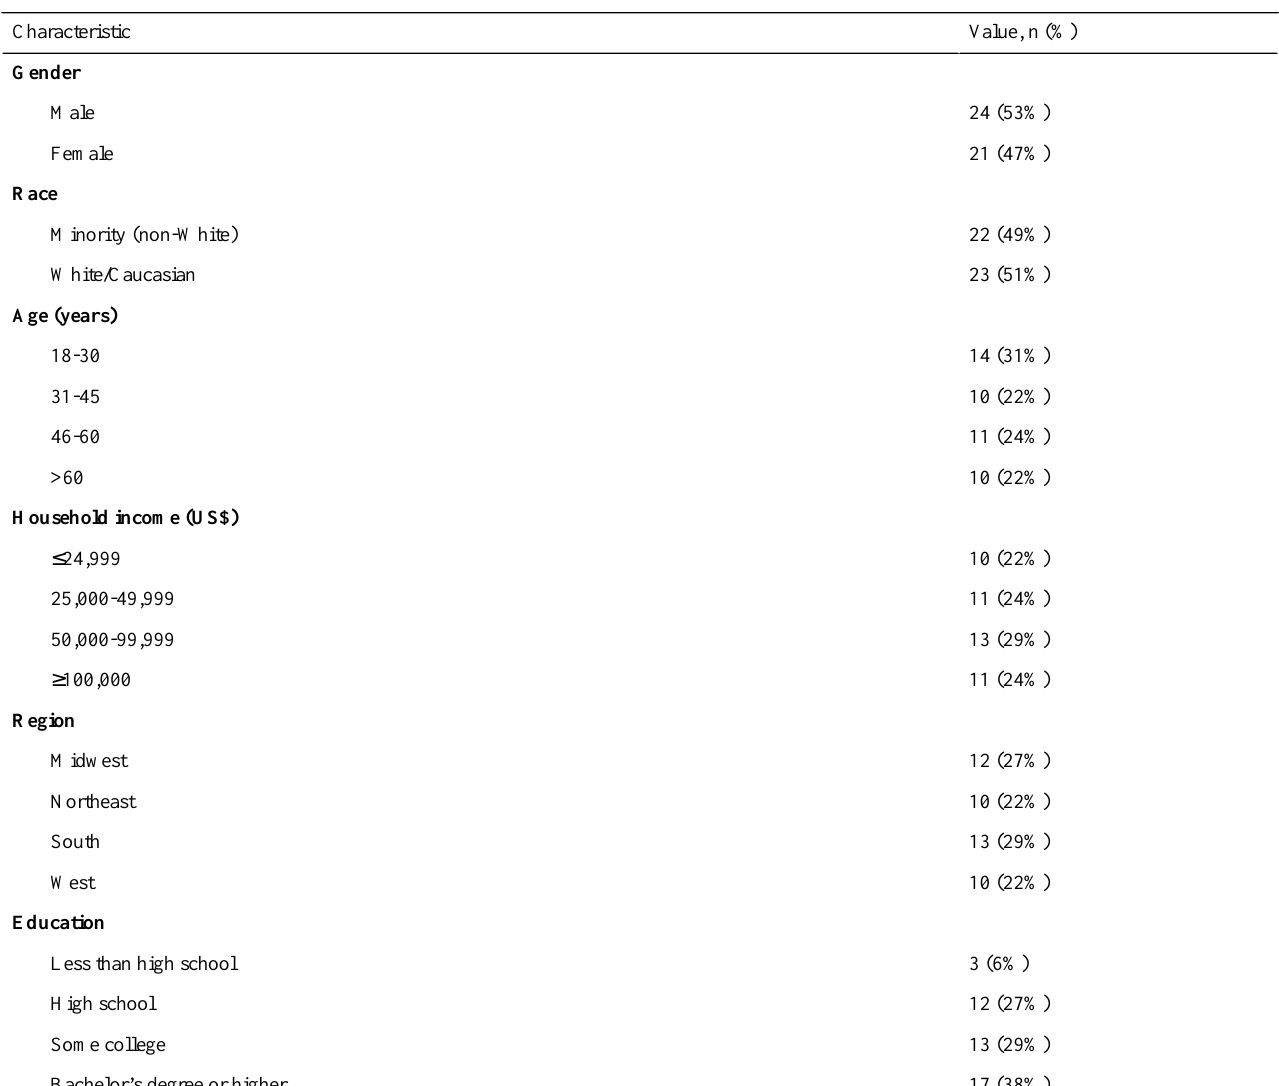
Table 2. Demographics of the participants (N=45).